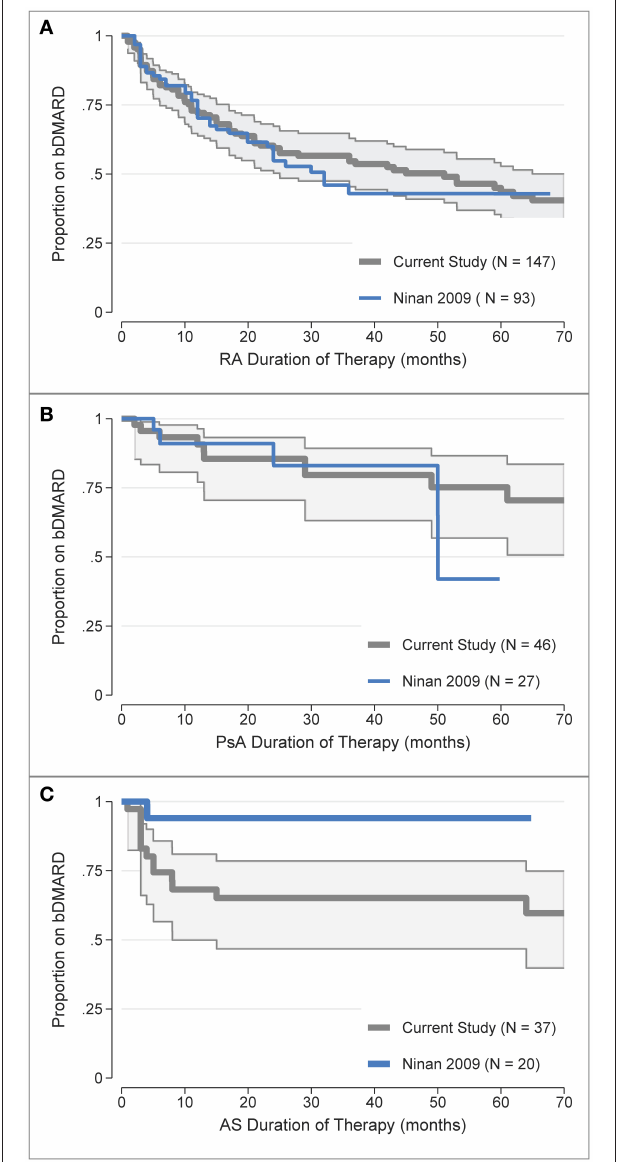
FIGURE 3 | Comparison of the first b/tsDMARD treatment retention rates in the current study (post-July 2008) with earlier (pre-July 2008) data from Ninan et al. (31) for: (A) Rheumatoid Arthritis (RA), (B) Psoriatic Arthritis (PsA), (C) Ankylosing Spondylitis (AS). The digitised data from the Kaplan-Meier curves in Ninan et al. (31). Figure 1 was overlaid against the Kaplan-Meier treatment retention curves for the first b/tsDMARD in the current study, with shaded areas representing 95% confidence intervals.